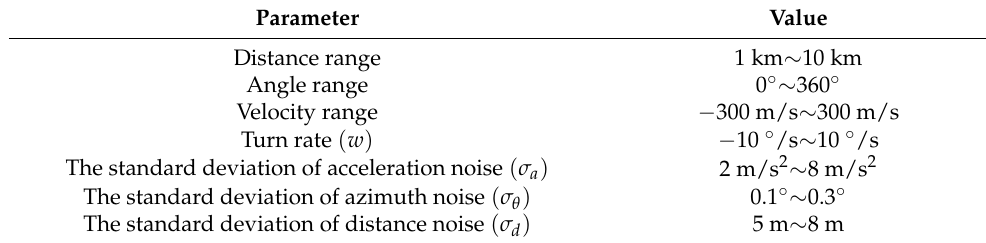
Table 1. Parameters of the trajectory dataset.